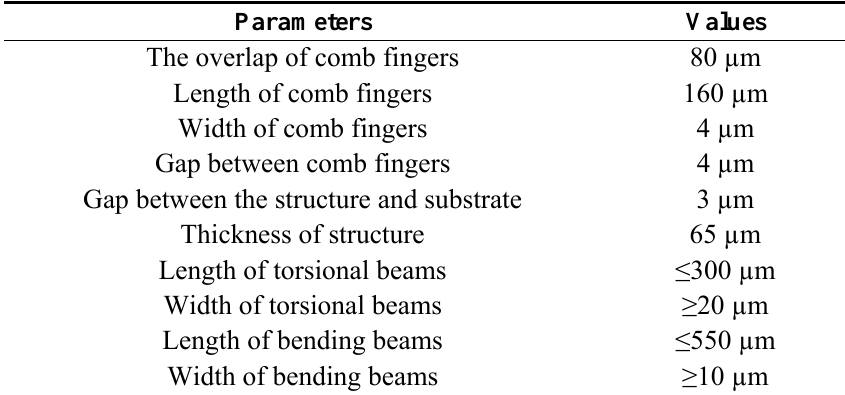
Table 1. The common geometry configuration for